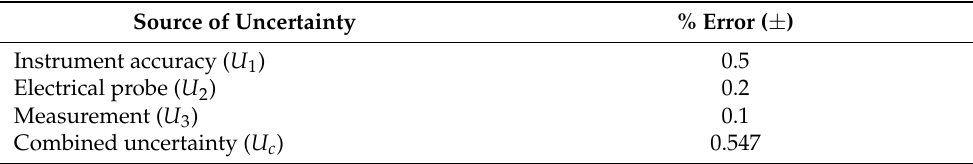
Table 4. Measurement uncertainty for thermal